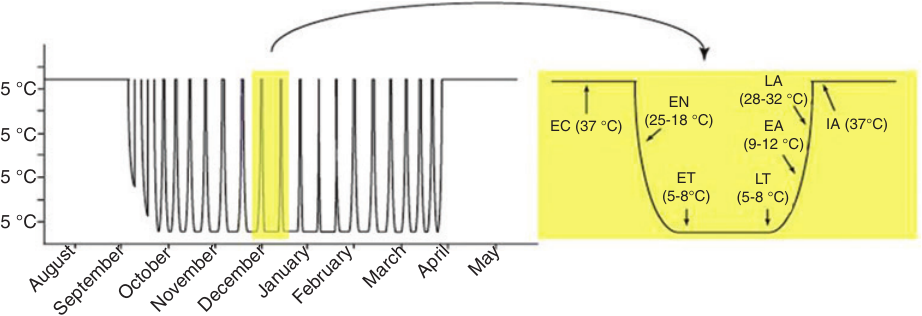
) of a thirteen-lined ground squirrel as a function of time over one hibernation season. Figure 5: Body temperature (T b Highlighted in yellow is one torpor-arousal cycle. The different stages are: (1) euthermic, cold room (EC), (2) entrance (EN), (3) early torpor (ET), (4) late torpor (LT), (5) early arousal (EA), and (6) interbout arousal (IA). Modified from ref.